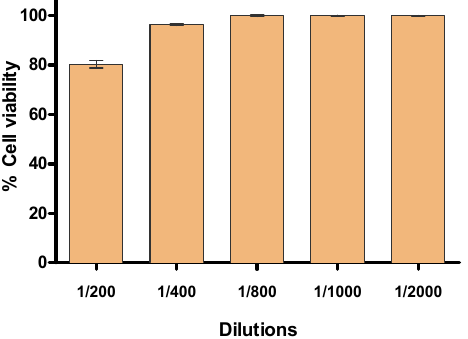
Figure 1. Percentage of cell viability of the HaCaT keratinocyte cell line exposed to different concen- D. peruviana EO. trations of D. peruviana EO. trations of